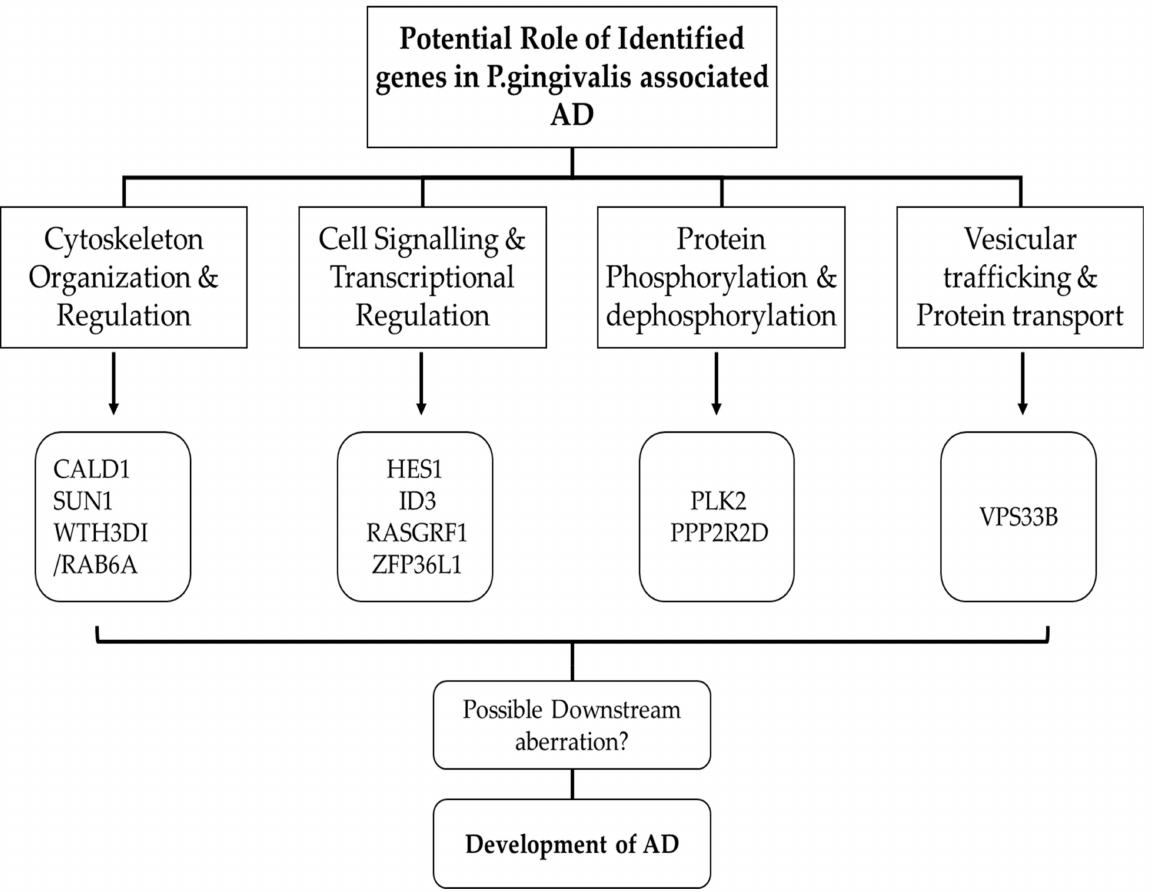
Figure 8. The functional characterisation of identified common